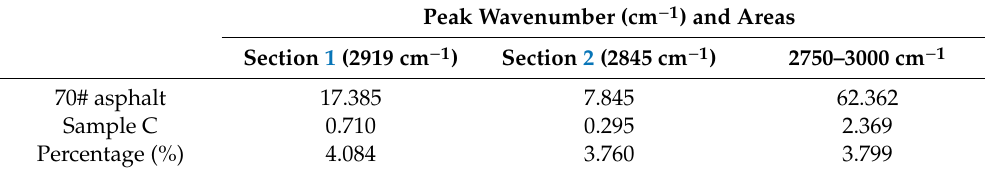
Figure 5. Adsorption mechanism for mineral powder: ( a ) adsorption; ( b ) adhesion; ( c ) sediment